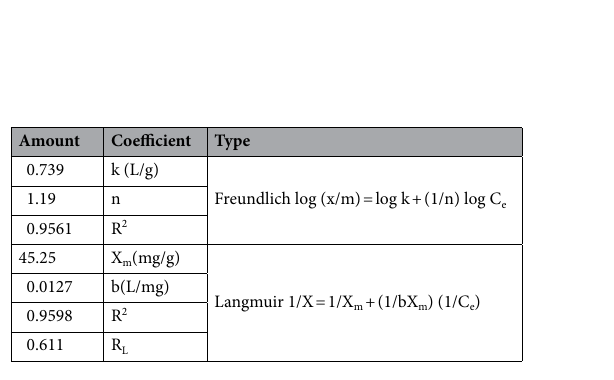
Table 3. Langmuir–Freundlich adsorption isotherm constants for chromium (VI)